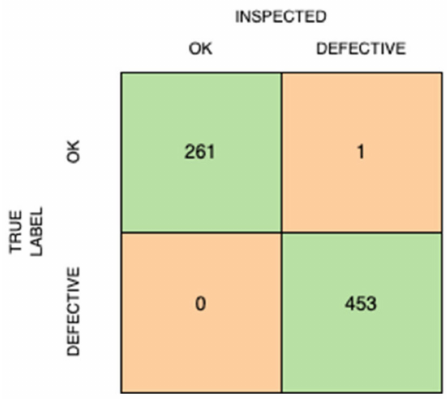
Figure 8. Confusion matrix showing the results of the inspection